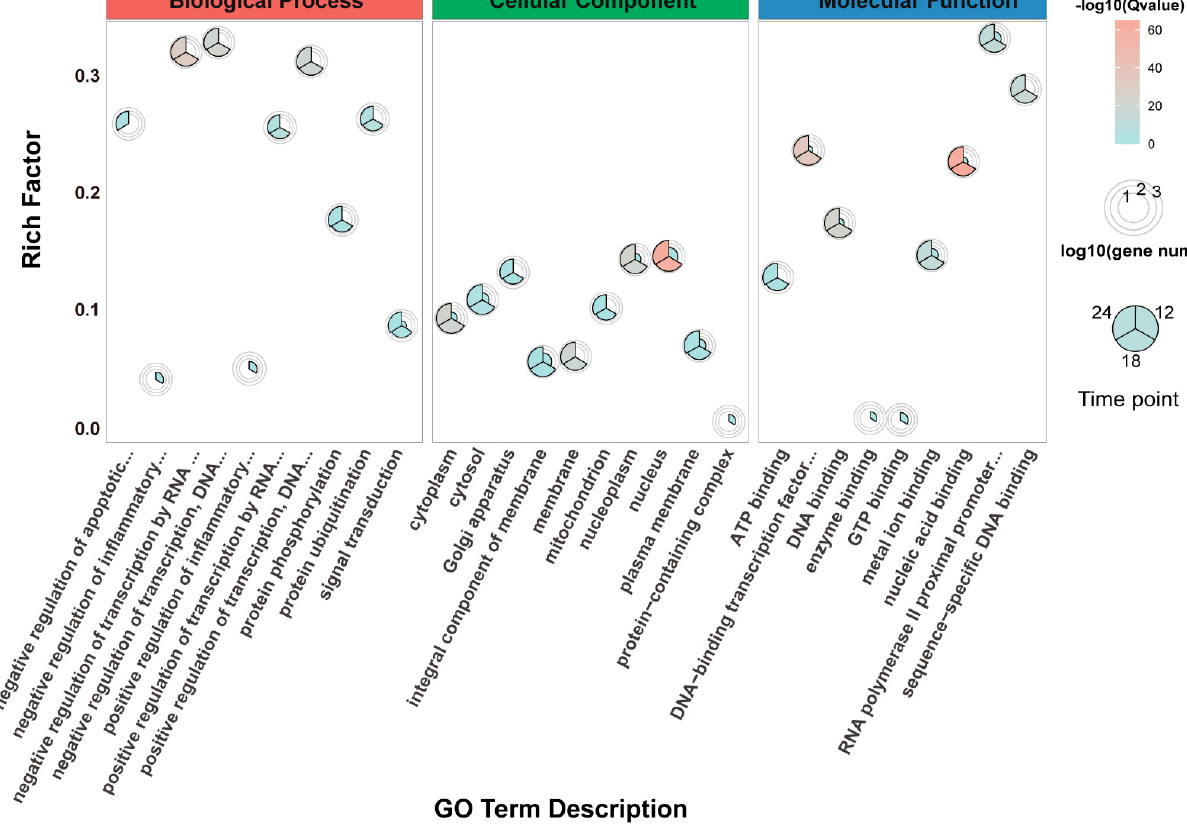
Figure 3. Gene ontology enrichment analysis of DEGs in SADS-CoV-infected Vero E6 cells at 12, 18, and 24 dpi. The circles of different sizes indicate the log10 value of gene numbers in each GO term. The circular sectors in different positions of circle indicate three time-points.